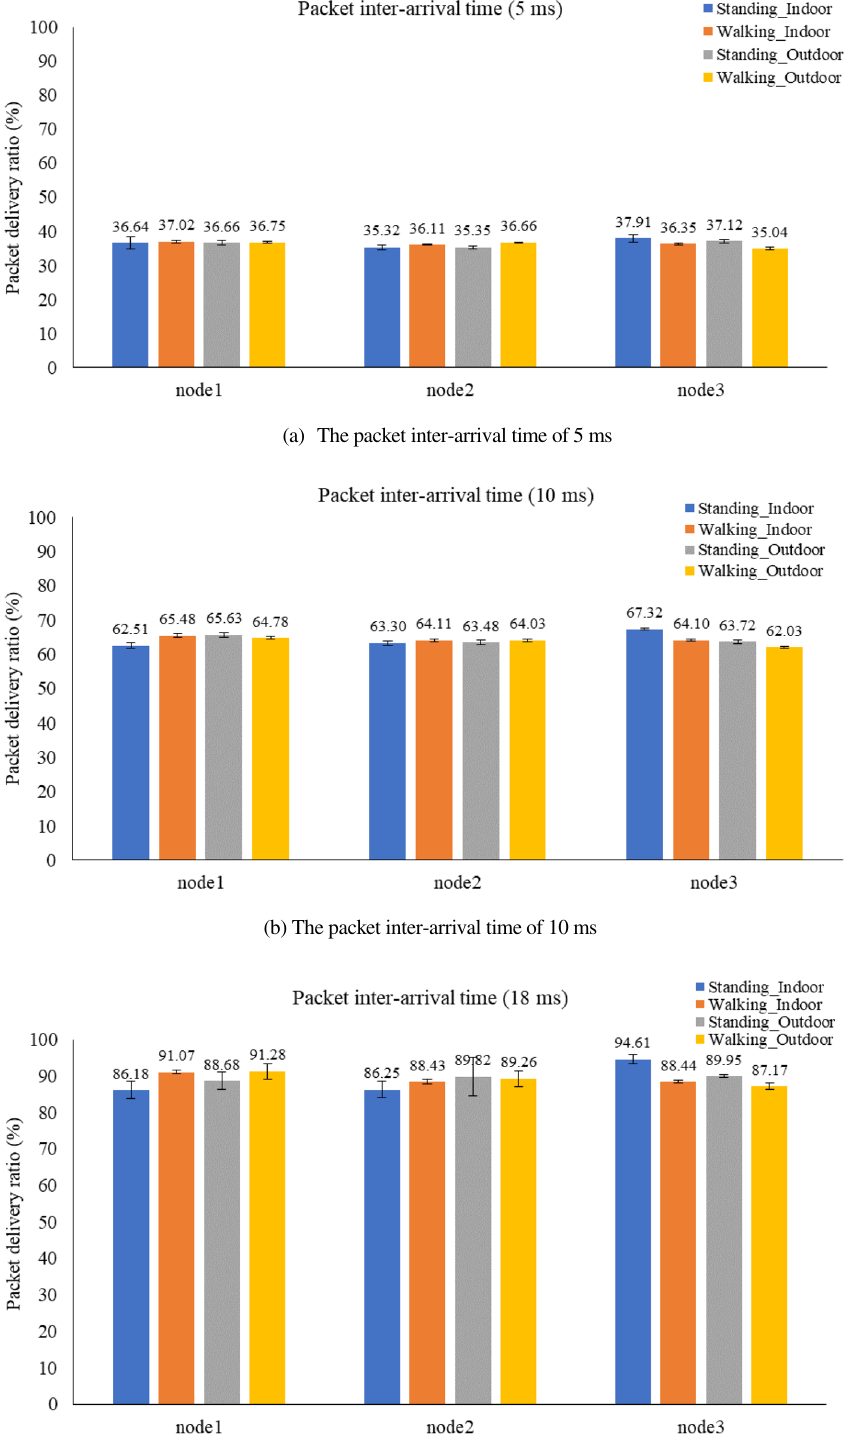
Fig. 13 The PDR for each transmitter node for the test cases #3 and #4. a The packet inter-arrival time of 5 ms. b The packet inter-arrival time of 10 ms. c The packet inter-arrival time of 18